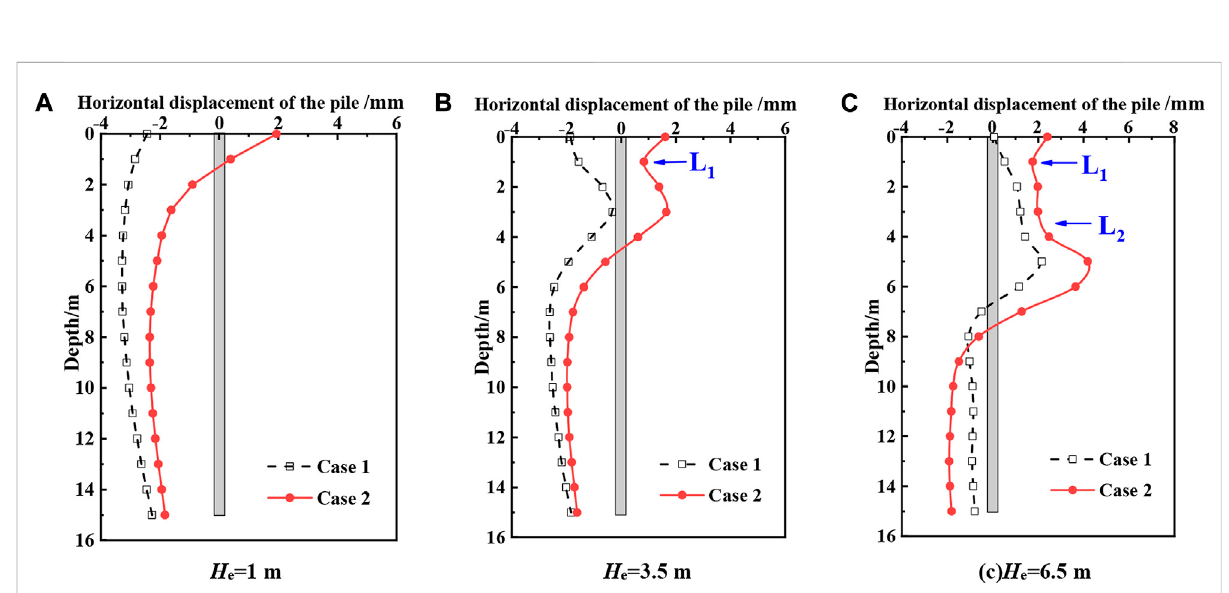
FIGURE 17 Comparison of horizontal displacement of retaining pile on the left side of excavation. (A) H e =1 m. (B) H e =3.5 m. (C) H e =6.5